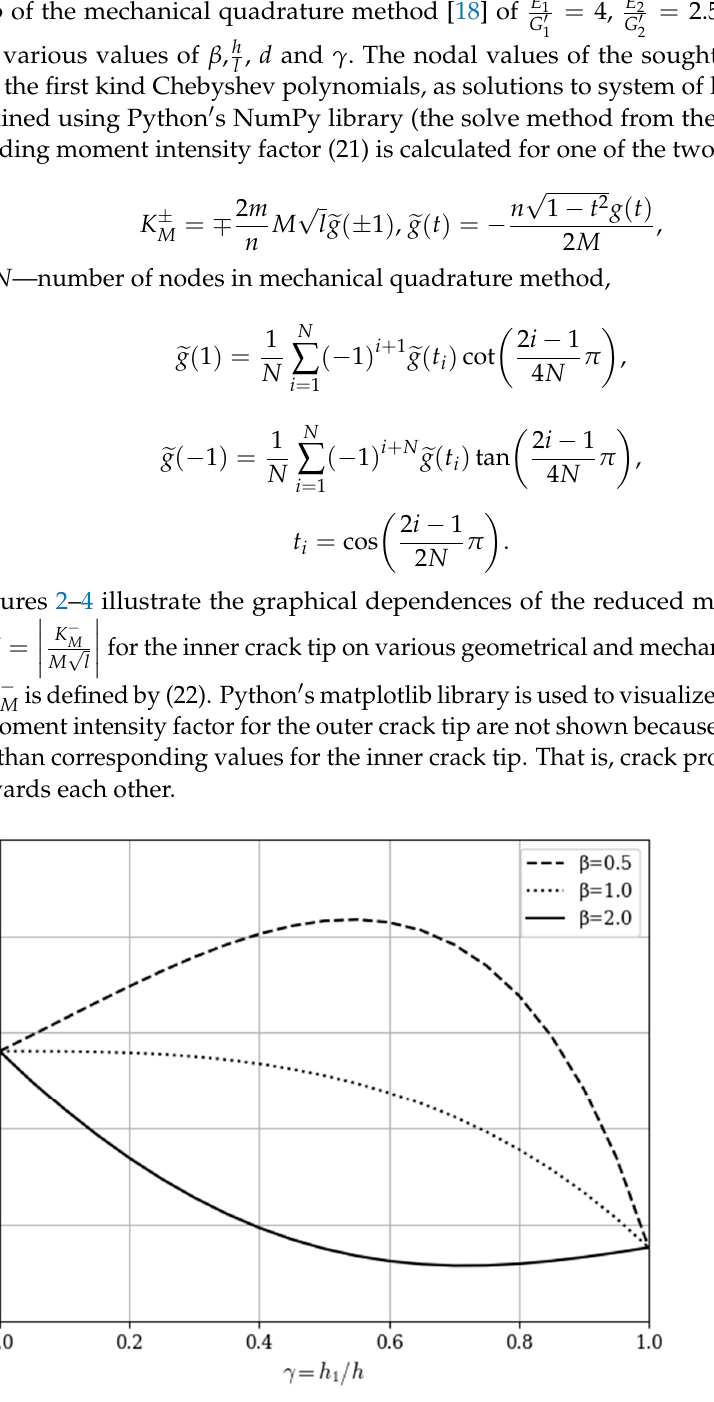
Figure 2. Dependence of the reduced moment intensity factor for inner crack tip on the layer thickness ratio γ = h 1 / h at h / l = 2 c / l = 1 and various values of shear modulus ratio β = G (cid:48)